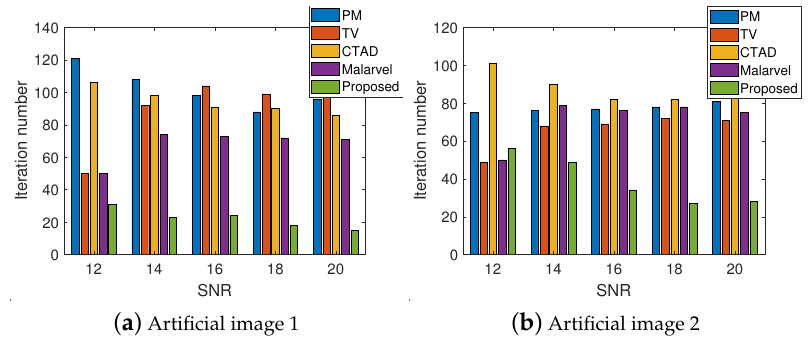
Figure 5. Iteration numbers.